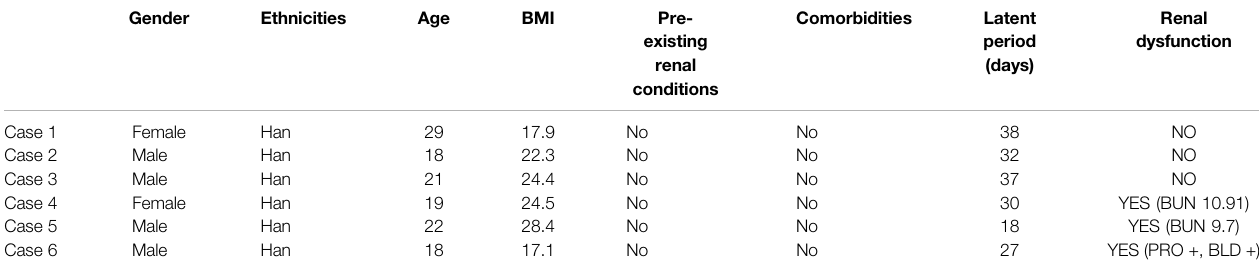
TABLE 2 | The baseline data of OMLDT patients in the present study. Gender